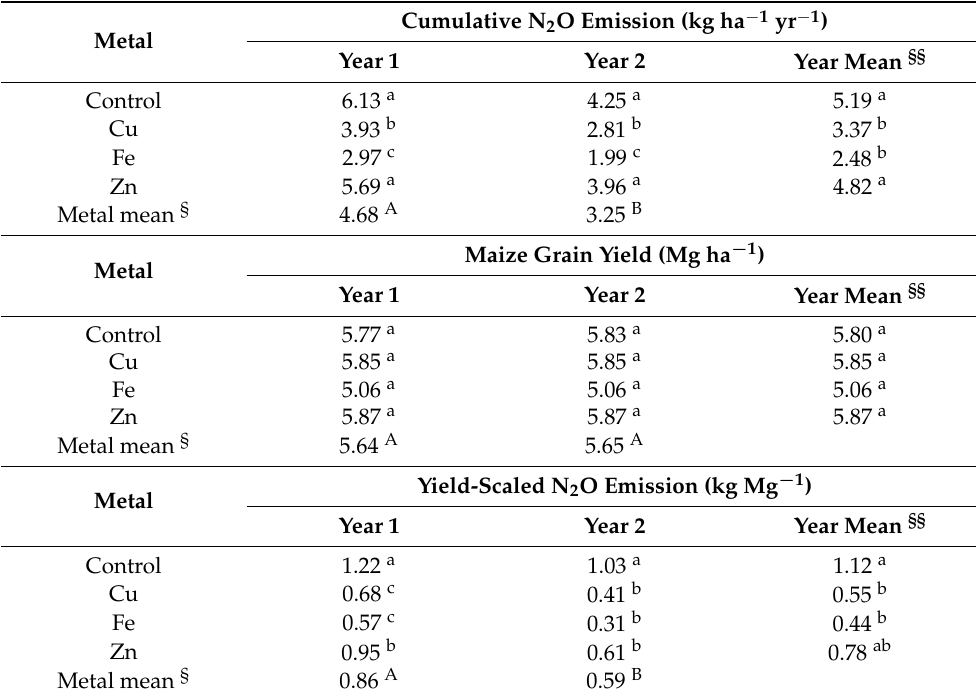
Table 4. Cumulative N 2 O emission, maize grain yield, and yield-scaled N 2 O emission from soils amended with different metals in Years 1 and 2.